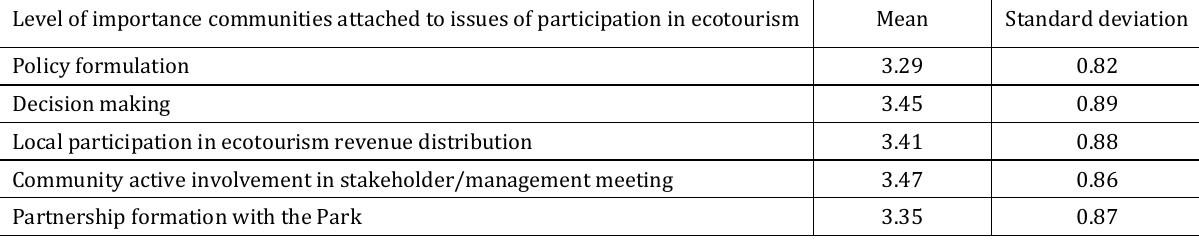
Table 5. Level of importance communities attached to issues of participation in ecotourism